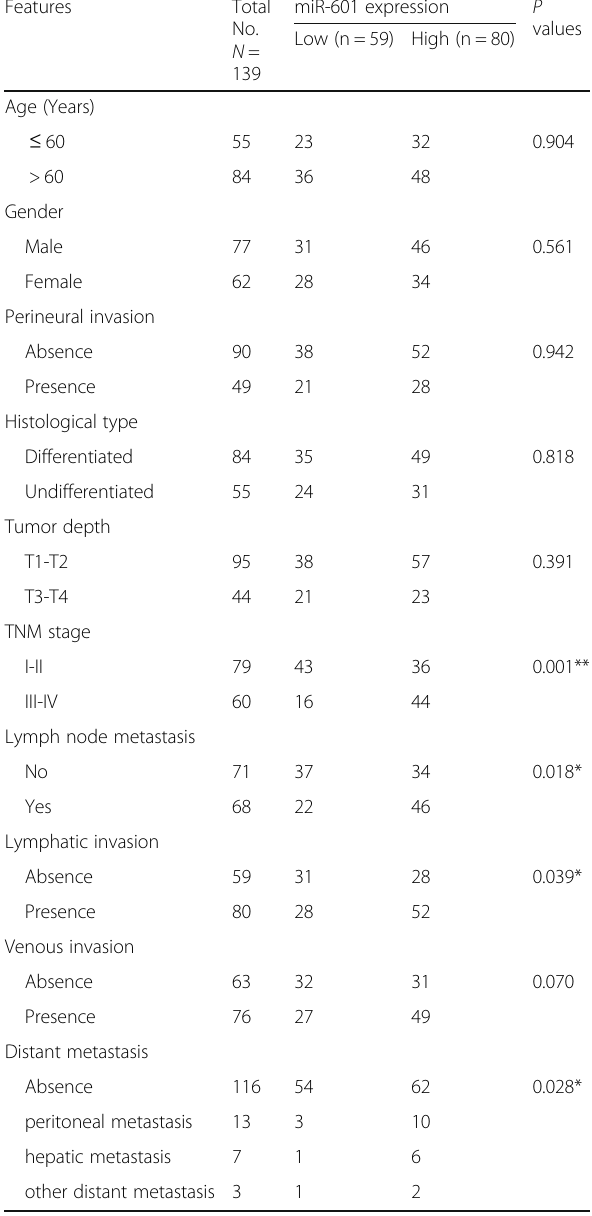
Table 1 Association of miR-601 with the clinicopathological features of gastric cancer patients Features Total